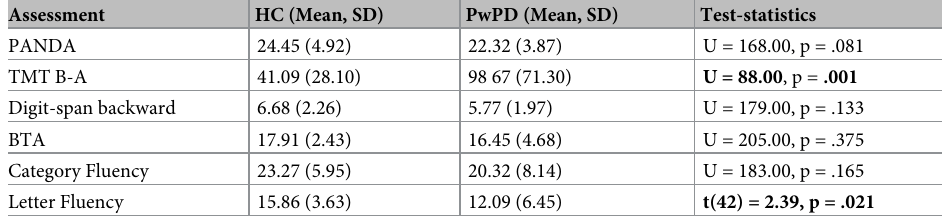
Table 3. Summary of group comparisons for cognitive tasks providing descriptive data as well as statistical results.